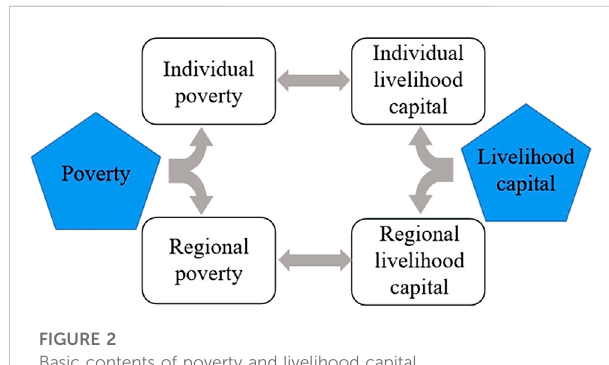
FIGURE 2 Basic contents of poverty and livelihood